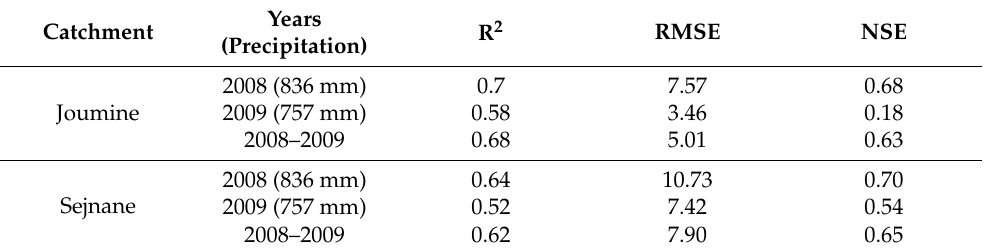
Figure 11. Simulation result of the discharge from Sejnane reservoir catchment with the parameters calibrated with Joumine reservoir catchment. Table 2. Evaluation of the runoff simulations for the catchments of Joumine and Sejnane.